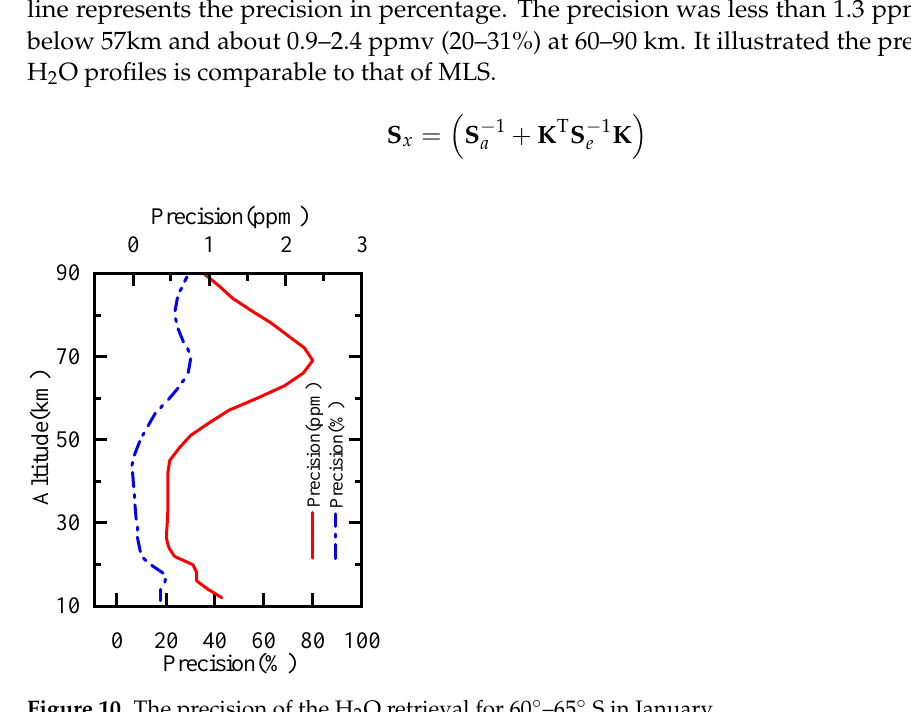
Figure 10. The precision of the H 2 O retrieval for 60 ◦ –65 ◦ S in January. The vertical resolution of the H 2 O retrieval was obtained from the full width at half maximum (FWHM) of the averaging kernels [29]. Figure 11 shows the averaging kernels and vertical resolution of H 2 O retrieval for 60 ◦ –65 ◦ S in January. The solid line is the averaging kernel at 12–85 km with different color representing different altitudes. The dashed line represents the vertical resolution. The vertical resolution of H 2 O profiles was better than 5 km below 32 km, and about 5–8 km between 35 and 85